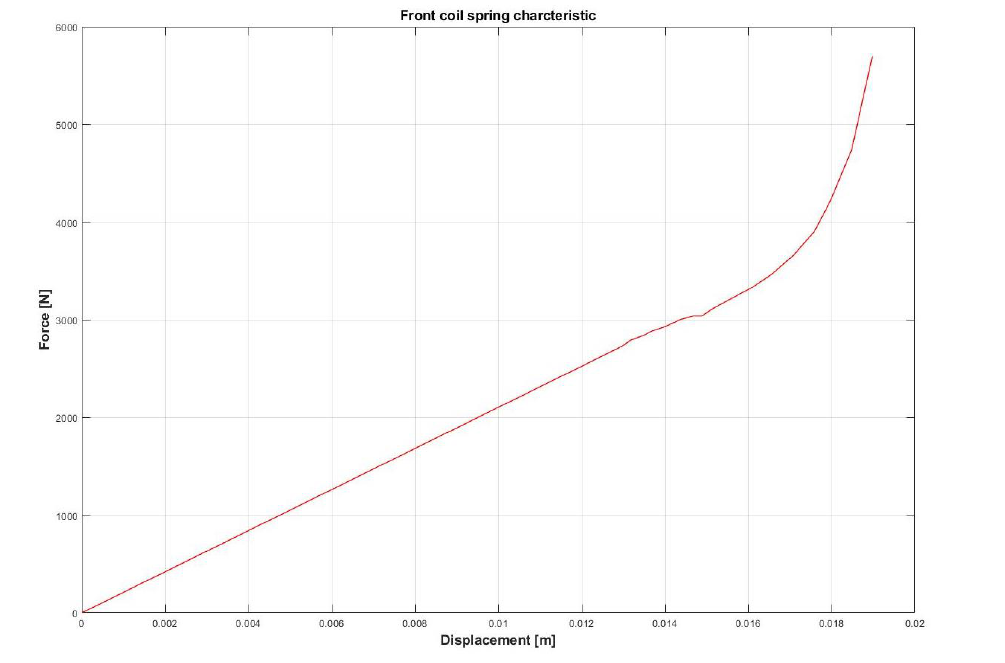
Figure 3. Front coil spring